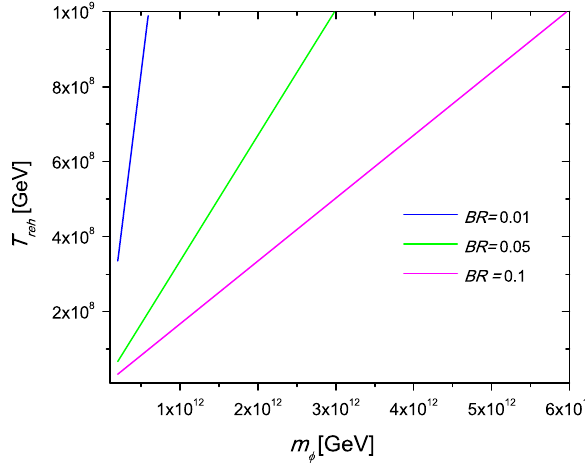
Fig. 3 Reheating temperature after inflation versus the inflaton mass (both in GeV) for three different values of the branching ratio, 0.01 (blue), 0.05 (green) and 0.1 (magenta)